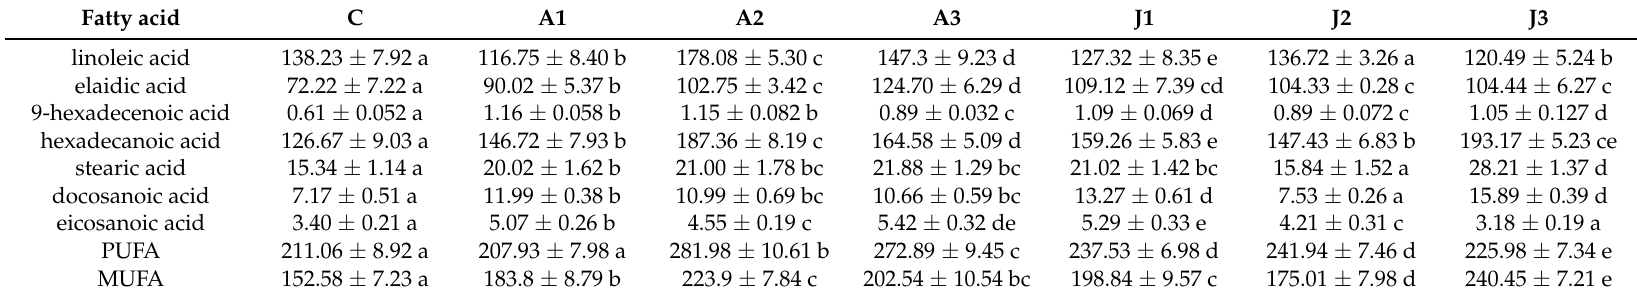
Table 3. Fatty acid composition in Cabernet Sauvignon berries after different treatments (mean ± SD, n = 3, mg · Kg − 1 ). Fatty